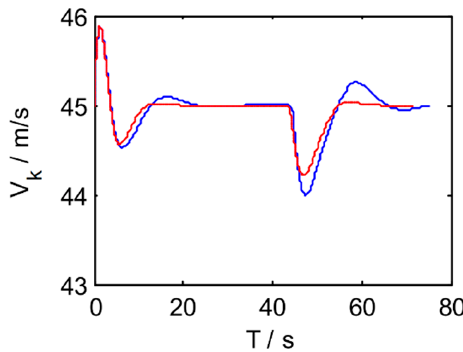
Figure 7. Air speed in windless conditions.